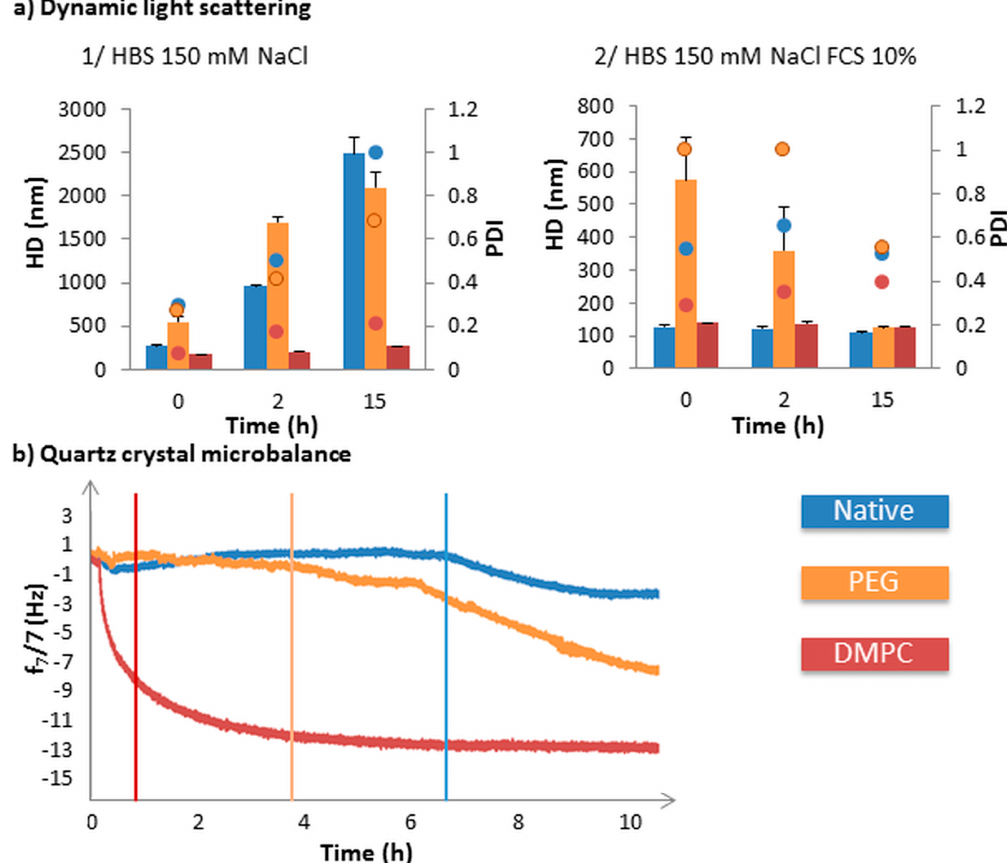
Figure 4. Characterization of native and coated Fe 3 O 4 @MSN behavior in suspension in complex media, with or without proteins. ( a ) (1) and (2): Hydrodynamic diameter (HD) and polydispersity index (PDI), represented respectively by bars and dots, for native (blue), polyethylene glycol (PEG) (orange) and dimyristoyl phosphatidylcholine (DMPC) (red) Fe 3 O 4 @MSN in (x) HEPES buffered saline (HBS) 150 mM NaCl (pH 7.4) and (y) HBS 150 mM NaCl (pH 7.4) containing 10% fetal calf serum (FCS). ( b ) Quartz crystal microbalance with dissipation (QCM-D) frequency sensorgram following the interaction between nanoparticles and the egg phosphatidyl choline (EPC)-supported lipid bilayer (SLB). Native (blue), PEG (orange), and DMPC (red) Fe 3 O 4 @MSN were flowed into HBS 150 mM NaCl 10% SCF medium on the top of EPC SLB, at a concentration of 0.25 mg mL − 1 of nanoparticles. After adding Fe 3 O 4 @MSN into the medium on the top of the EPC SLB for 15 min, the flow